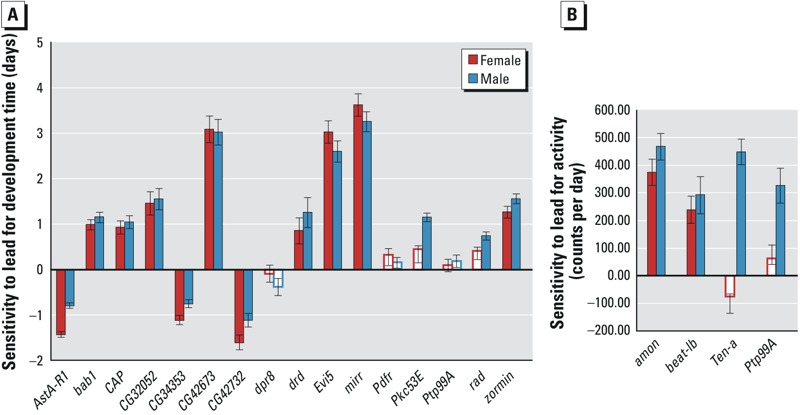
Mutational analysis of candidate genes associated with variation in sensitivity to lead exposure for development time (A) and activity (B). The bar graphs represent differences between mutants grown on lead and control medium minus the differences of co-isogenic control flies grown on the corresponding media. Red bars indicate females and blue bars indicate males that show significant differences between the mutants and the control as indicated by a statistically significant Line by Treatment interaction term (p < 0.05) in an ANOVA analysis of form Y = μ + L + T + L × T + ε, where L designates mutant and control, T indicates treatment and ε the residual error variance. White bars indicate no significant differences. Values in panel A are derived from 5 replicates with 50 larvae per replicate and in panel B from 30 flies per sex.